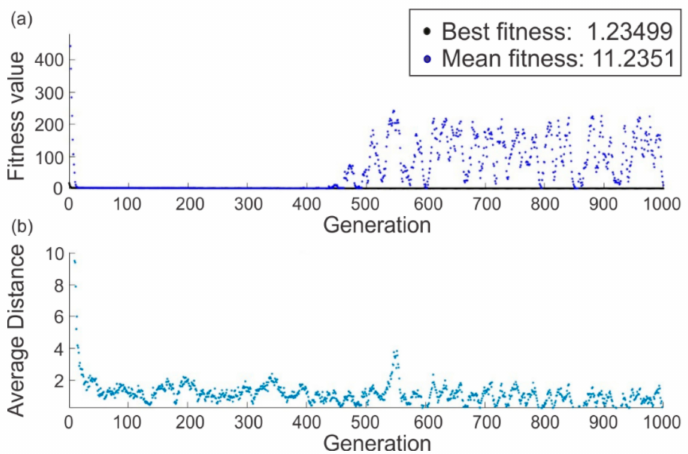
Figure 18. The transition of the fitness function. ( a ) Fitness value plot. ( b ) Average distance plot.